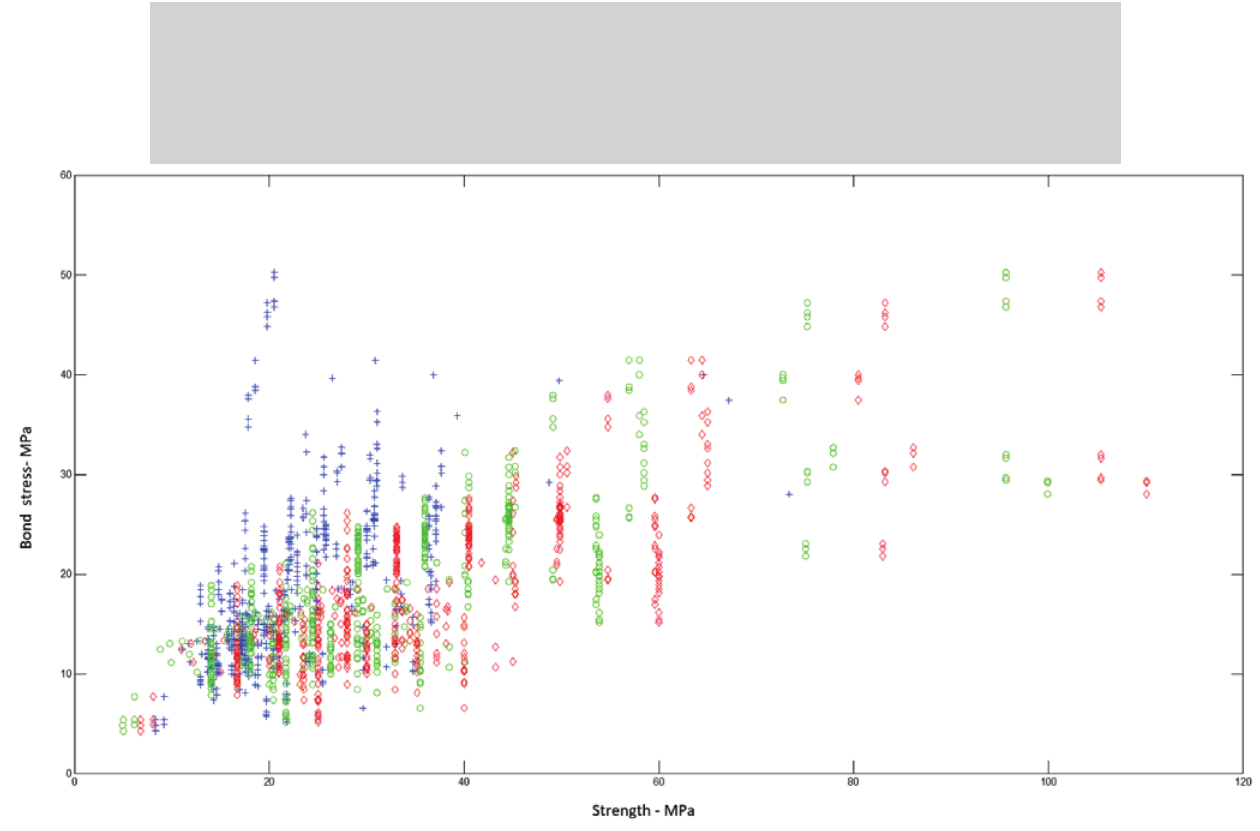
Artificial Neural Network modeling - ANN